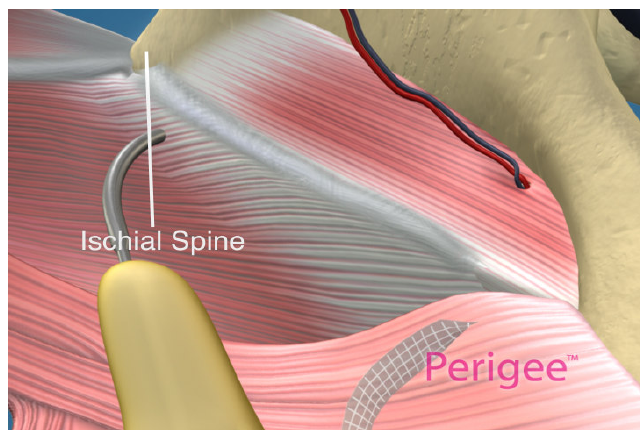
FIGURE 7 . Apical needle pass of Perigee System through side